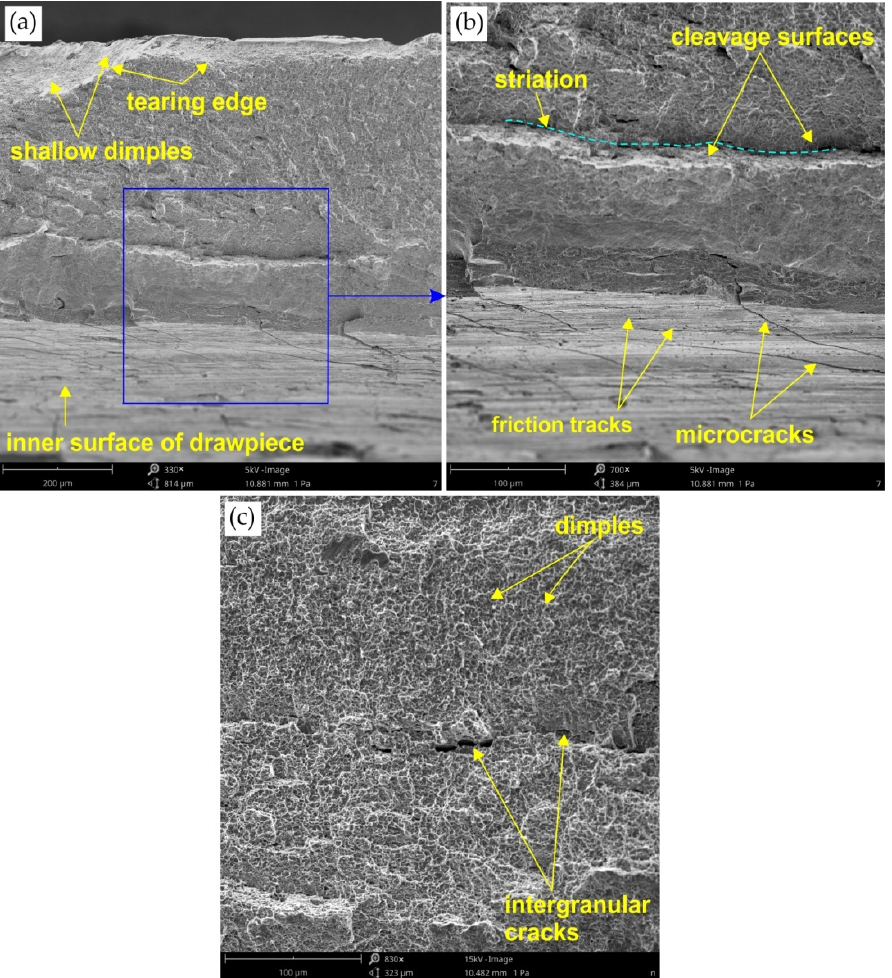
Figure 8. SEM micrographs of the fracture surface of VWACF produced in run 15: ( a ) cross-section of the fractured surface, ( b ) view of the near-edge inner surface of the drawpiece, ( c ) magnification of the ductile fracture area.